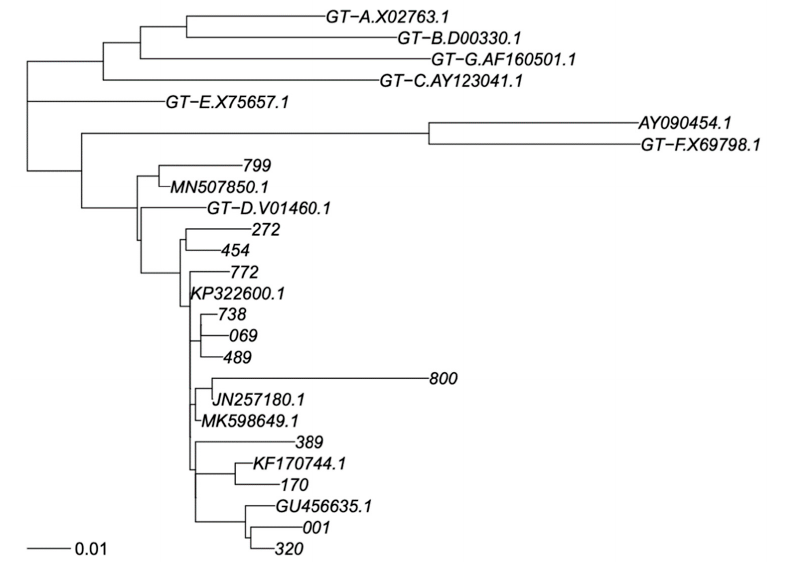
Figure 1. Phylogenetic tree of RT sequence fragment. Legend: Phylogenetic tree for genotype classification of RT segment. Genotyping reference sequences are labelled “GT-X”, where X indicates genotype, followed by the GenBank accession number. Our new sequences are labelled with a three-digit numerical code, and the closest sequences in GenBank are labelled with their accession number. The scalebar is in units of substitutions/site. Trees were constructed as described in Materials and Methods.